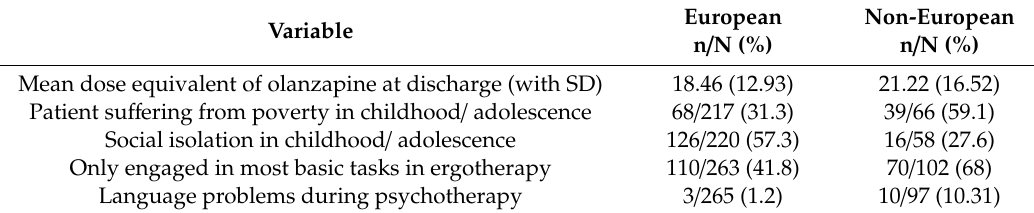
Table 3. Absolute and relative distribution of predictor variables.